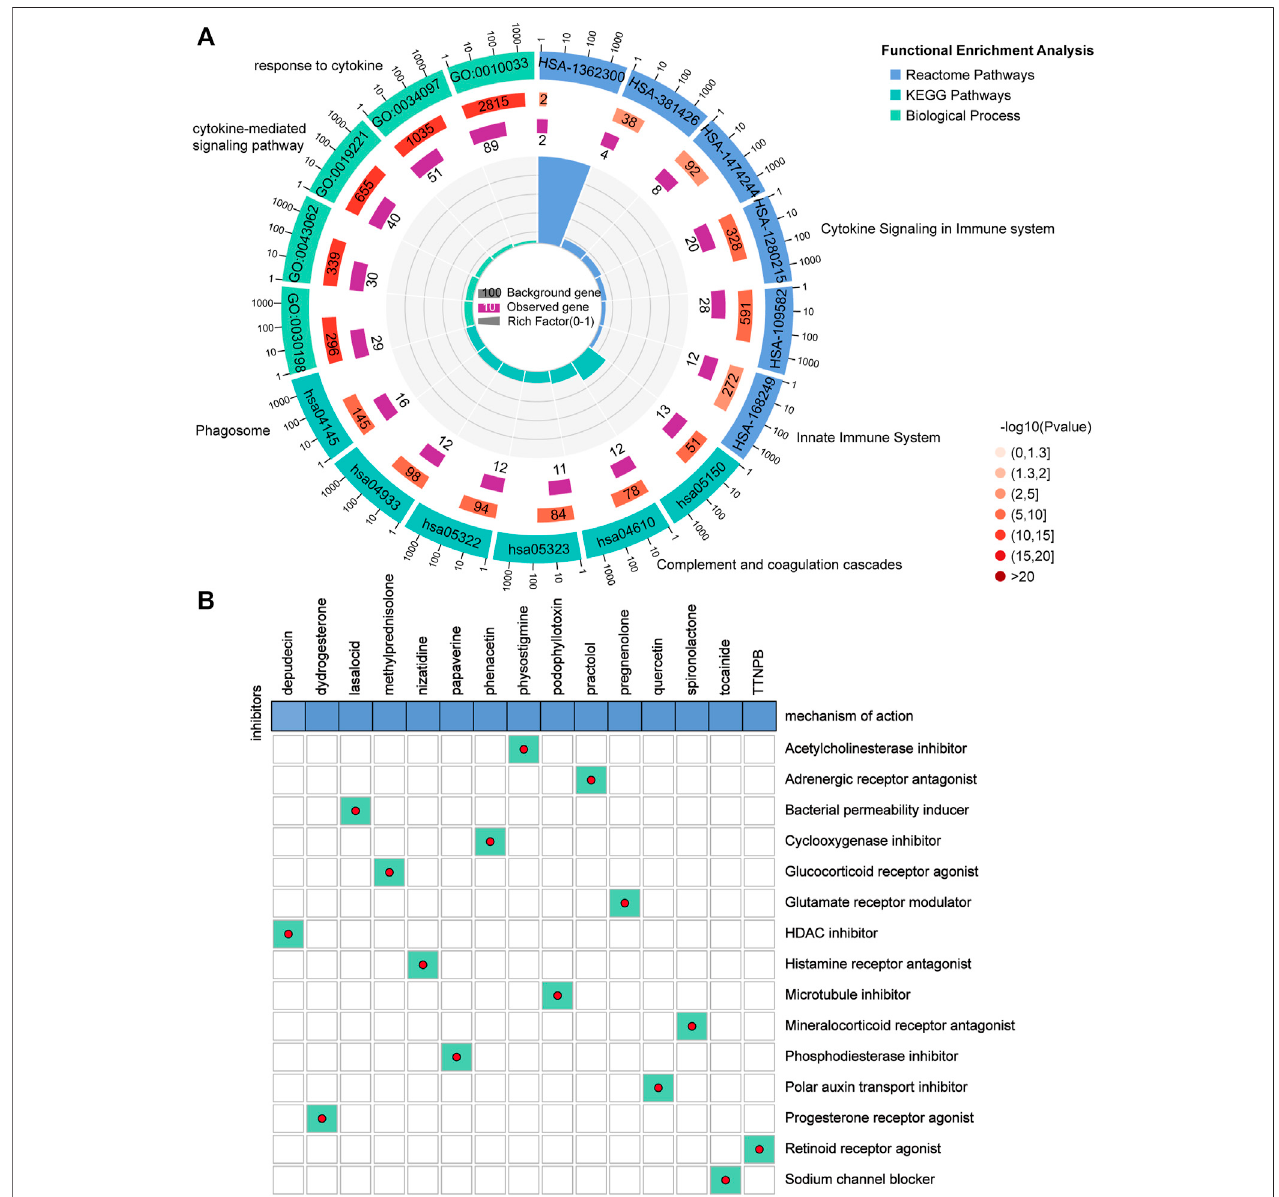
FIGURE 10 | Potential small molecule compounds based on PRGPI. (A) Function enrichment analysis results of 263 DEGs between the high and low FRGPI groups. (B) Candidate small molecular drugs and mechanisms of action were discovered based on FRGPI. The abscissa represents the drugs, and the ordinate represents drug mechanisms of